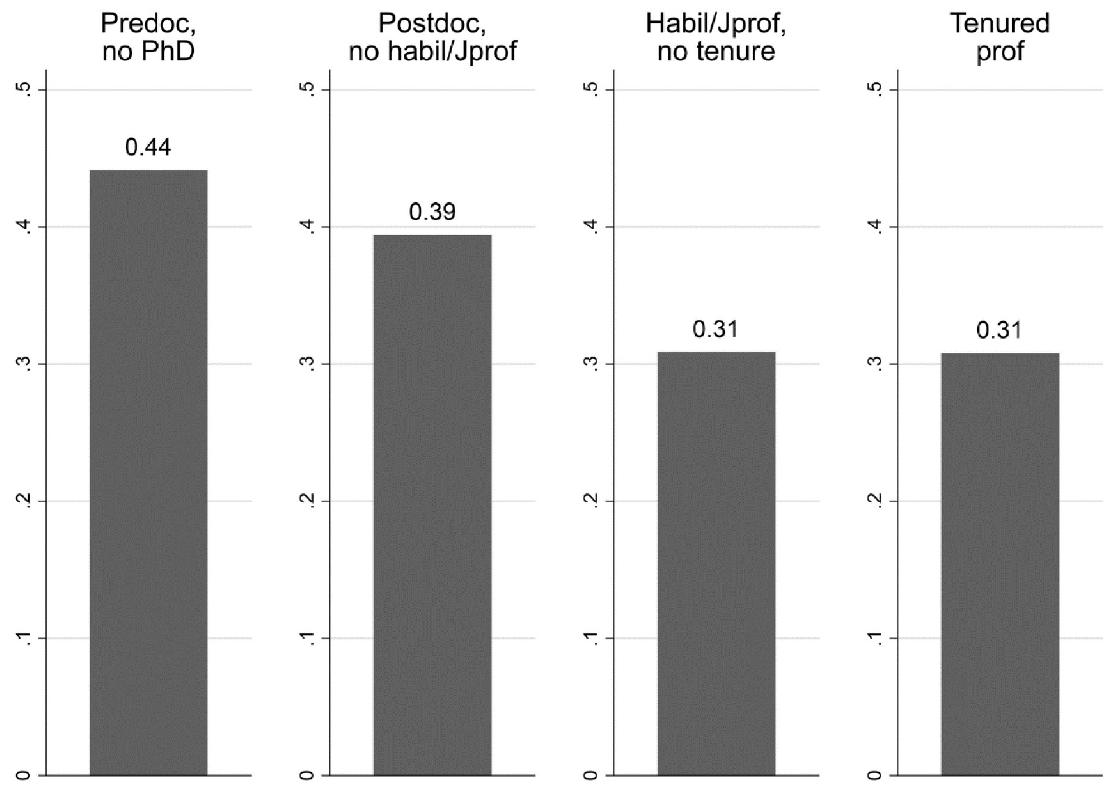
Fig 1. Share of women at each career